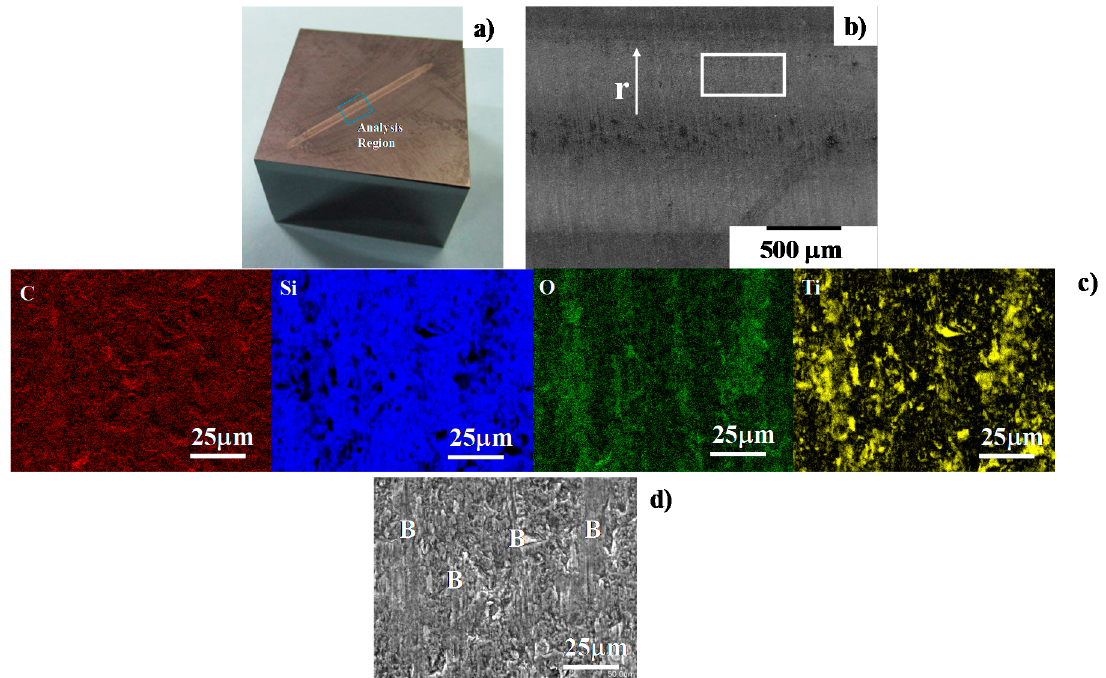
Figure 11. SEM and EDX analyses away from the center of the contact interface between the SiC-coated punch and the titanium wire after forging by 10 shots up to the reduction of the diameter by 35%. ( a ) Optical microscopic image on the SiC coating punch surface; ( b ) SEM image in low magnification on the contact interface of the SiC coating; ( c ) element mapping by C, Si, O and Ti and ( d ) SEM image in high magnification away from the center, where “B” represents the titanium oxide deposits.